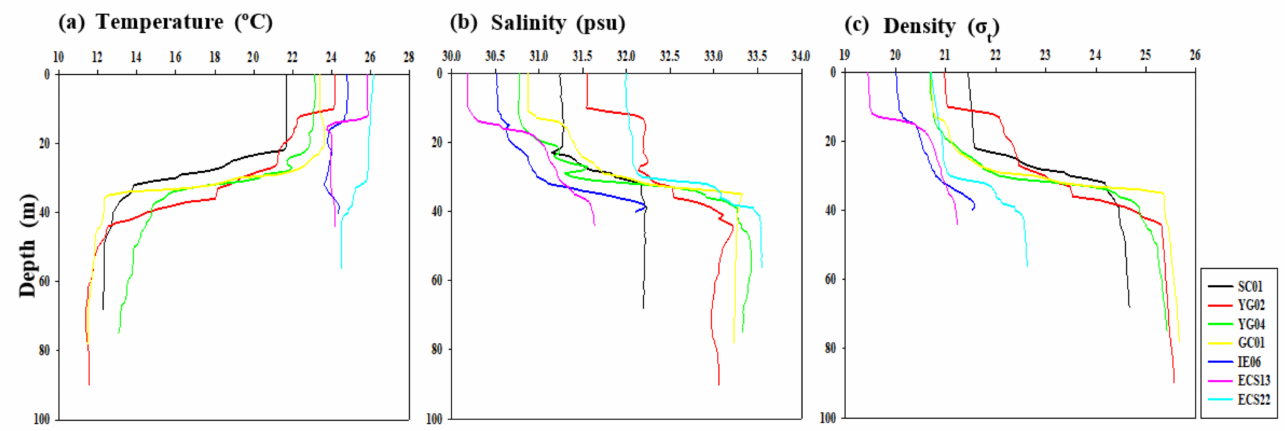
Figure 2. Vertical profiles of ( a ) temperature, ( b ) salinity, and ( c ) density at all the experimental stations of the YS and ECS for late summer of